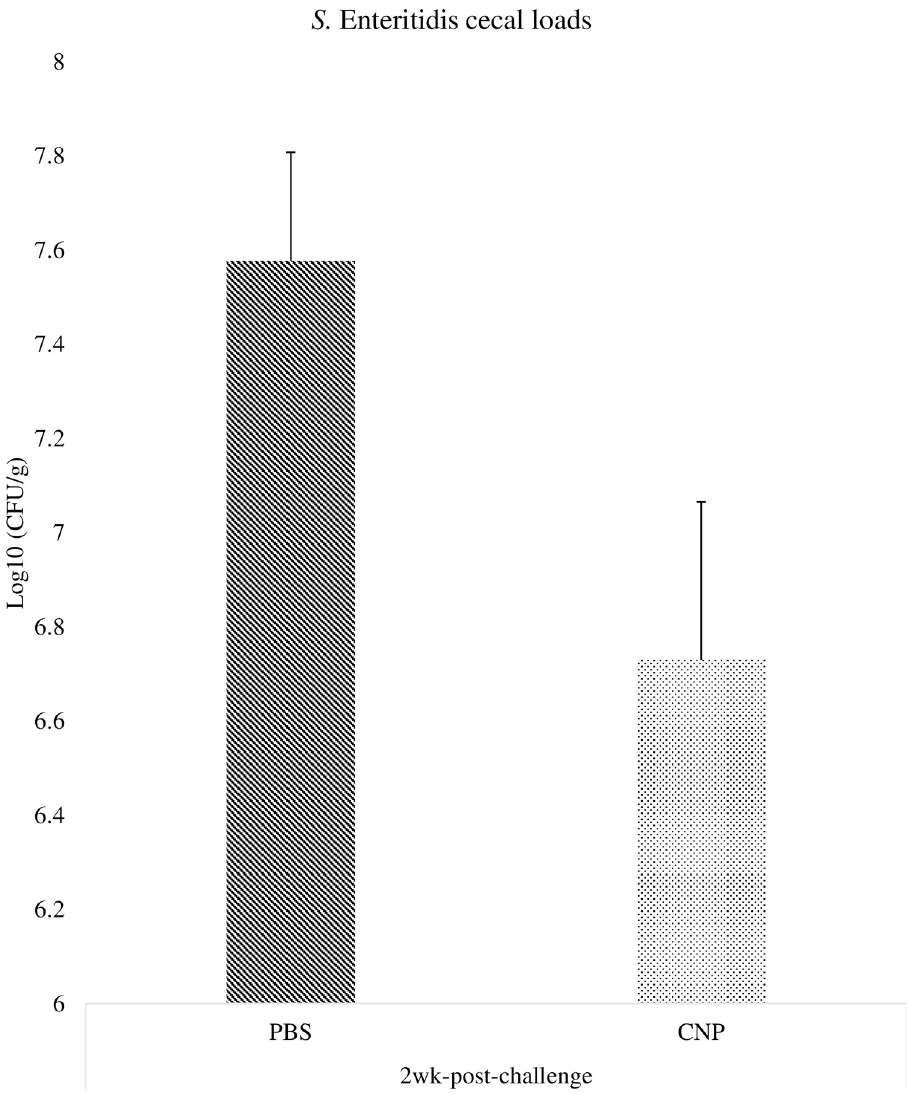
Fig 5. Salmonella loads in the ceca of chickens vaccinated in-ovo with CNP at 2wk-post-challenge. At embryonic d18, broiler eggs were vaccinated with either PBS (control) or 1000 μ g CNP vaccine. At d7 of age, birds were challenged with live SE (1.0 × 10 9 CFU/bird). Ceca samples were collected from 3 birds/pen, pulled, and stomached for enumeration by plating on XLT-4 agar. Salmonella enumeration data were recorded as CFU/g of ceca and then transformed to Log 10 CFU/g of ceca for statistical analysis. Data analyzed by parametric Student t-test; Means+SEM. Bars. n = 6. " � " means P < 0.05.